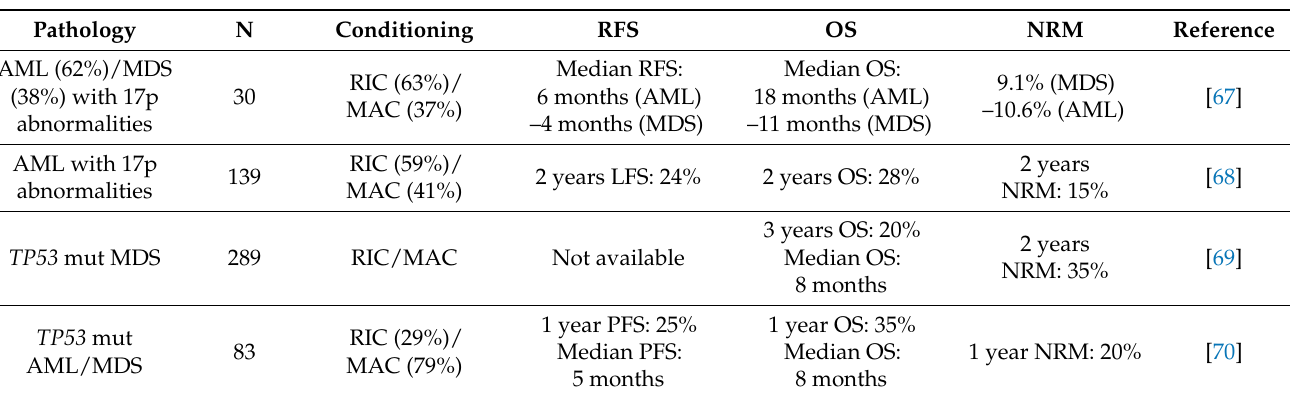
Table 4. Outcome of TP53 -mutated myeloid malignancy patients after allogeneic stem cell